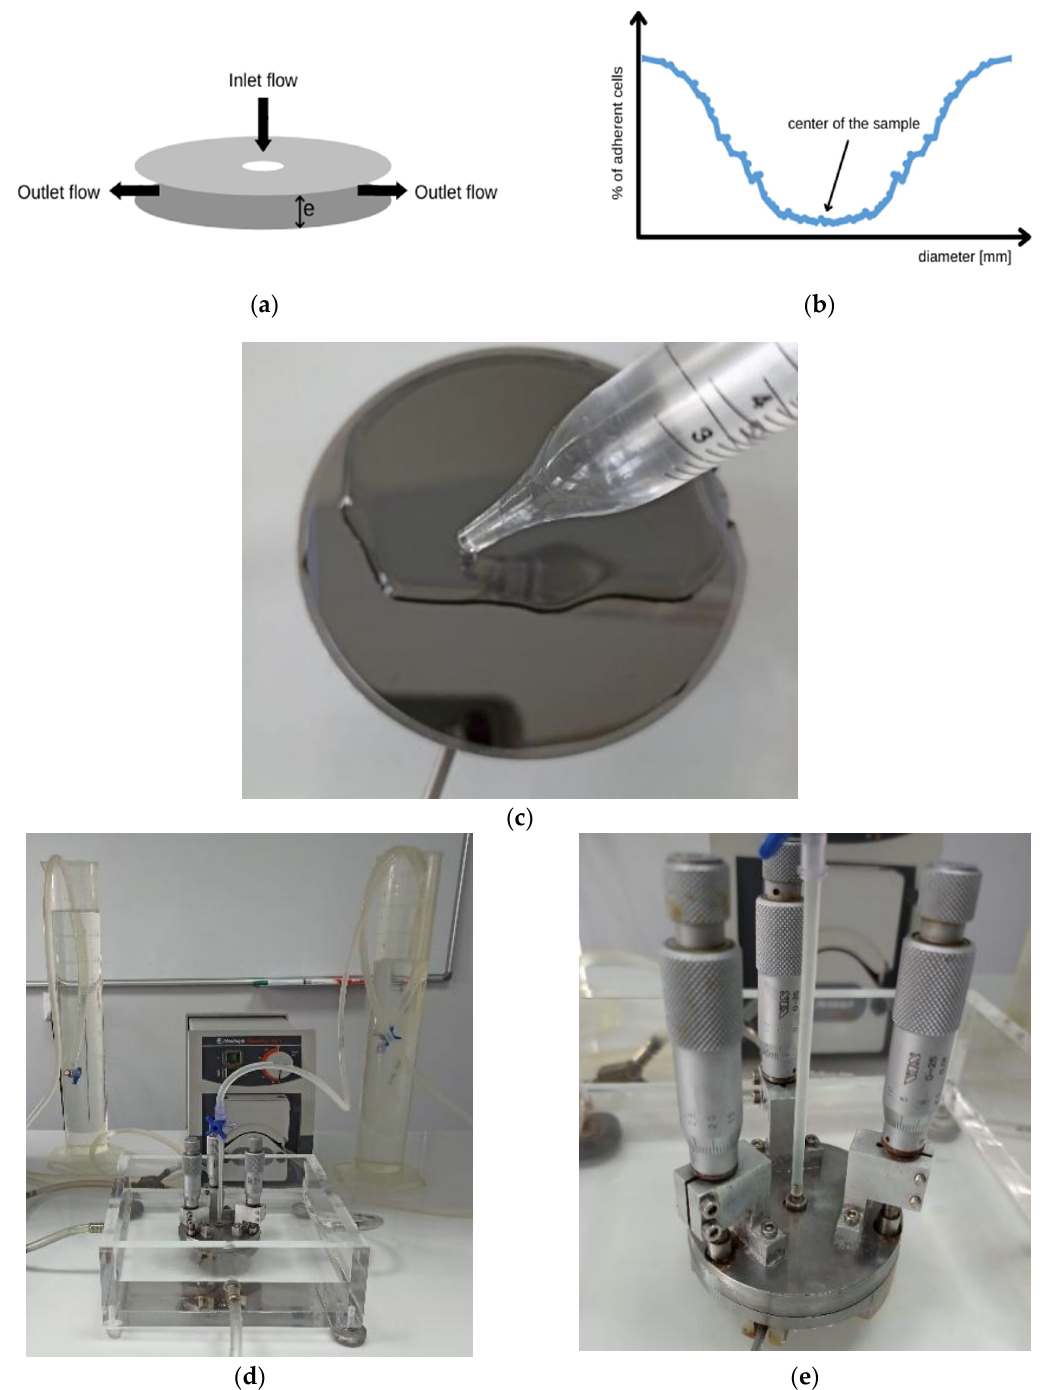
Figure 2. ( a ) Schematic of radial flow chamber; ( b ) Typical graph pattern obtained from results after the radial flow cell test; ( c ) Method of applying the solution of morphotic elements to the sample; ( d ) Experimental setup of radial flow chamber; ( e ) Tripod-flat stainless-steel disc (80 mm diameter) pierced in its center (1.5 mm orifice diameter).